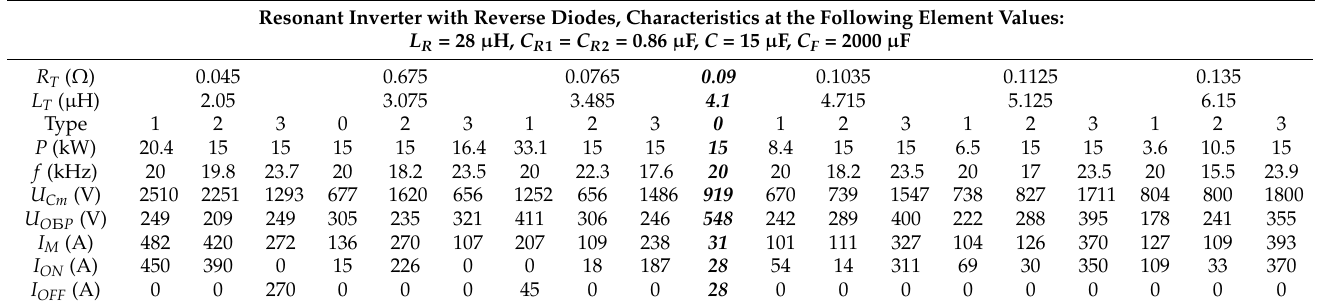
Table 2. Characteristics of the RI with an RD.